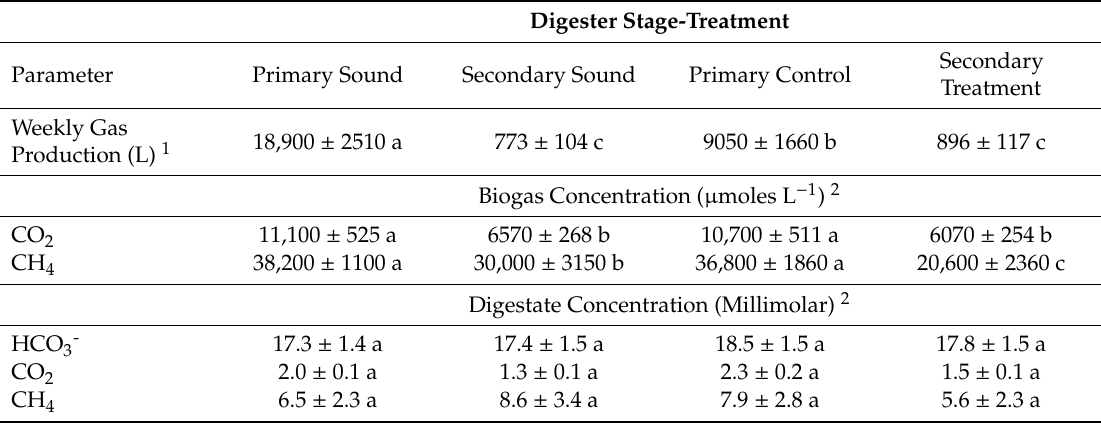
Table 2. Biogas production, quality, and dissolved biogas concentrations during the principal evaluation period from July 3 through October